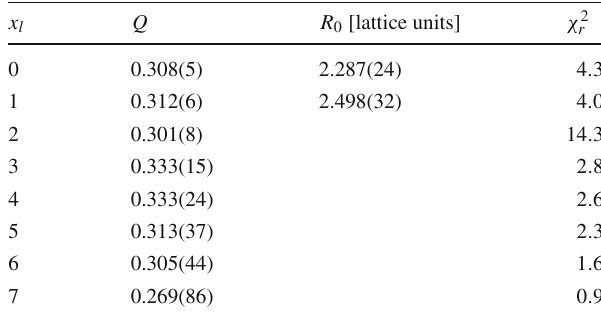
Table 3 Values of the fit parameters extracted from Coulomb fits of the E